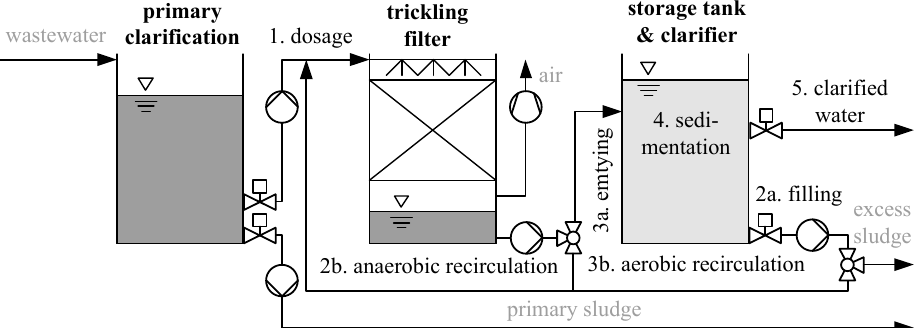
Figure 4. Principle schema of the trickling filter system [27].